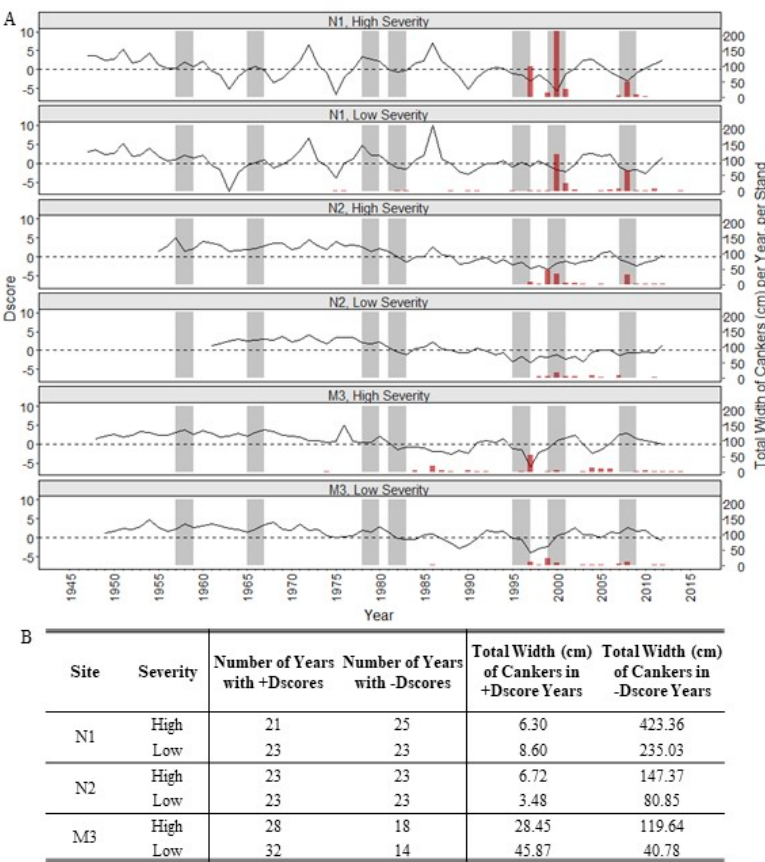
Figure 7. Decline scores (D scores ) associated with the annual summed width of canker damage, separated by site and Caliciopsis symptom severity class. ( A ) Black solid lines represent annual D scores (averaged per severity class and site). Black horizontal dashed lines represent the decline cutoff; D scores < 0 are declining stands. Gray vertical bars represent specific climatic events plus a 2-year post-event window (1957–1959, 1965–1967, 1978–1980, 1981–1983, 1995–1997, 1999–2001, 2007–2009). Red vertical bars represent the summed width (cm) of cankers per severity class, per site, per year. ( B ) The sum of years and canker widths in both positive and negative D score years, for 1967–2012.